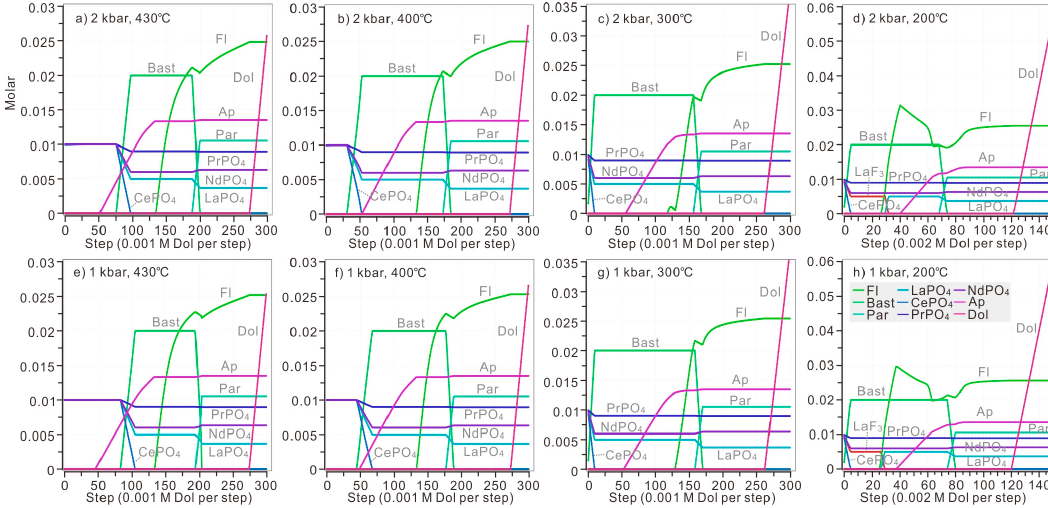
Figure 8. The replacement of bastnaesite by monazite when dolomite was introduced stepwise. Different amounts of dolomite were added in the calculations under different P and T: 0.001